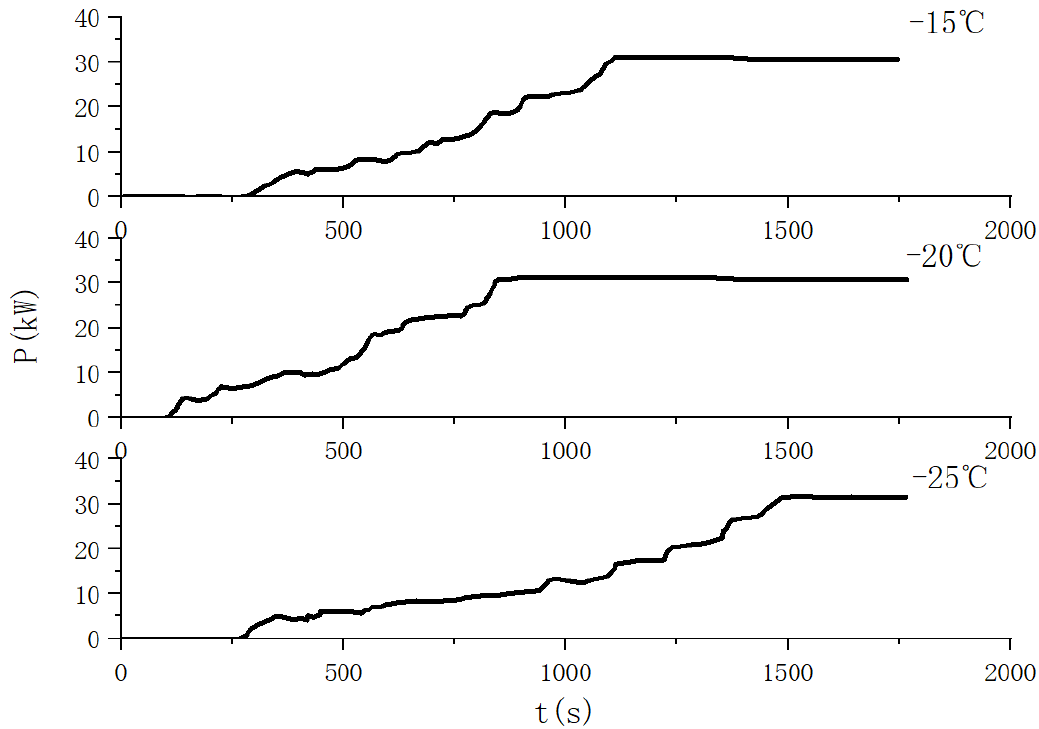
Figure 4. Graph of the power change in Stack A with time.